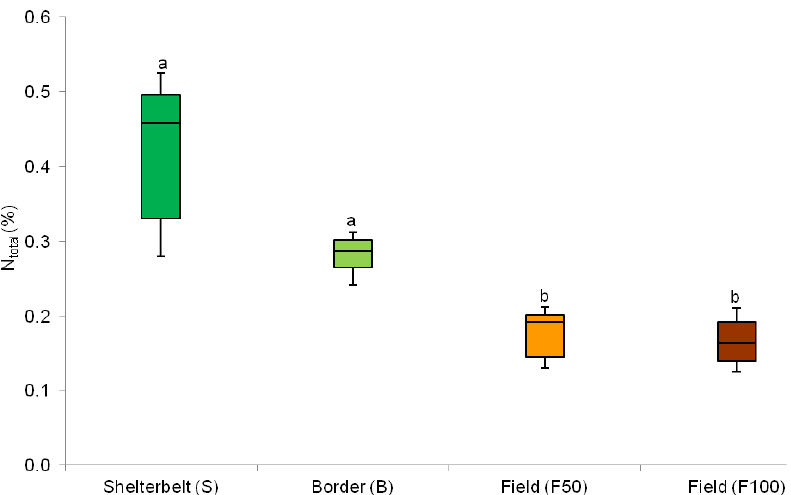
Figure 3. Box plots and results of one-way ANOVA showing the effect of soil use on total nitrogen (N total ) content along the measurement transect. The top hanging bar represents the high edge, and the lower hanging bar is the lower edge; − m edian; □ quartile 25–75%; significant difference at p < 0.05; n = 9; different letters indicate significant differences.